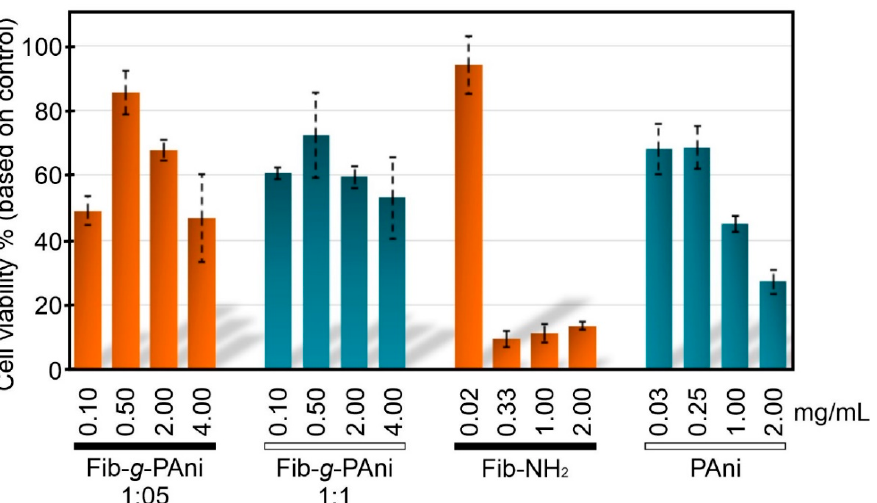
Figure 8. Cell viability of NIH/3T3 fibroblast cells treated with Fib- g -PAni (1:1 and 1:0.5), Fib-NH 2 , and PAni, taking the viability of untreated cells as a reference